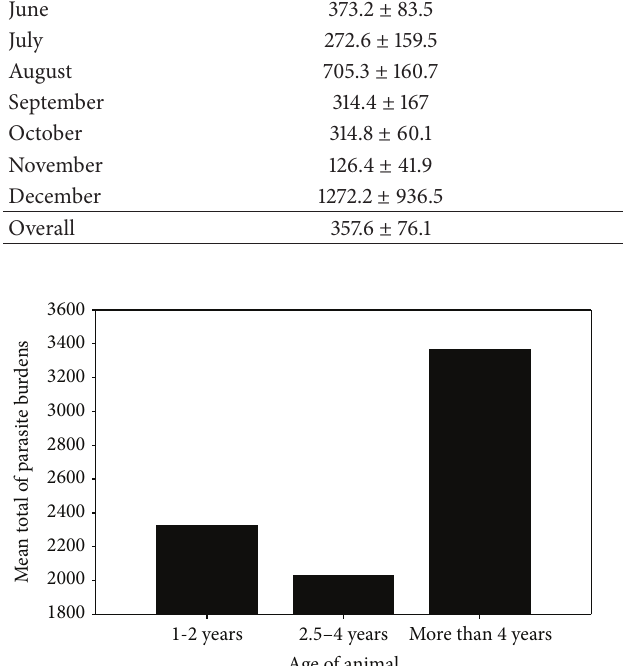
Figure 3: Effect of age on the parasitic burden on infected donkeys.